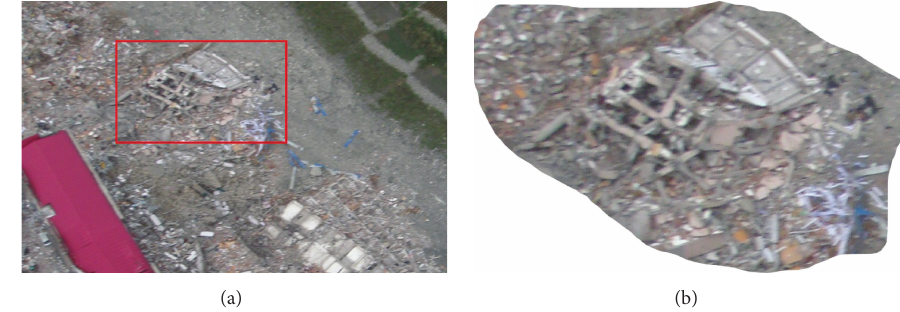
Figure 7: The interactive selection and segmentation result of aerial